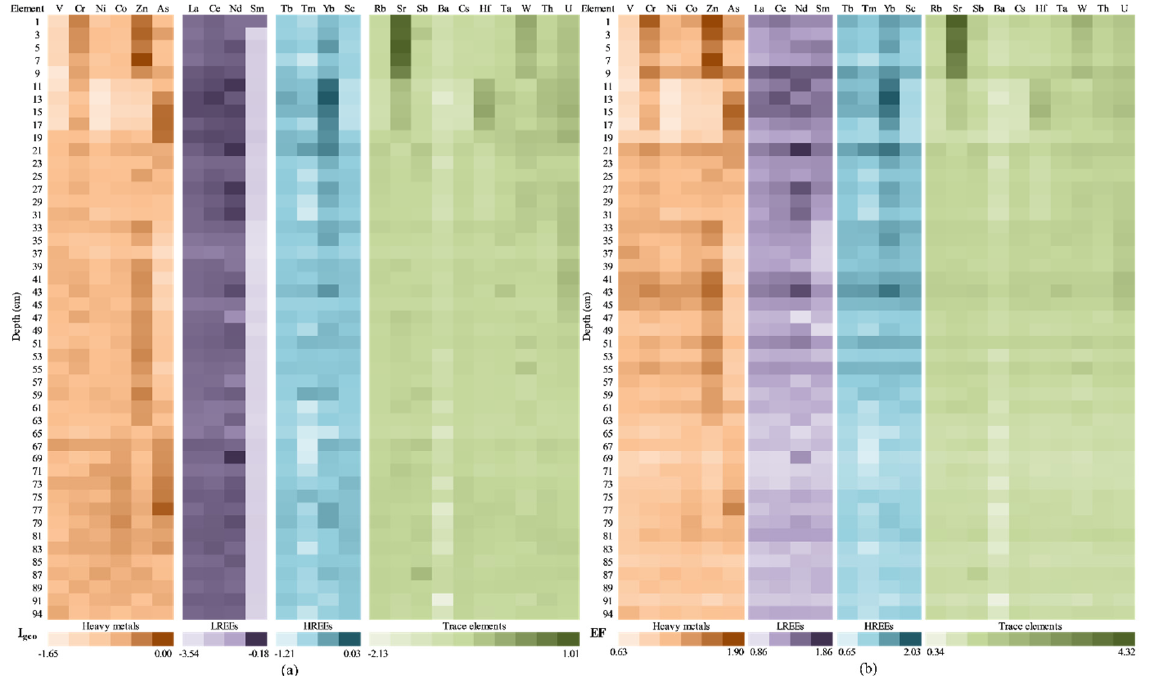
Figure 15. Geoaccumulation indices (I geo,s ) ( a ) and enrichment factors (EFs) ( b ) calculated from the Amara Lake sediment core (94 cm depth). Amara Lake sediment core (94 cm